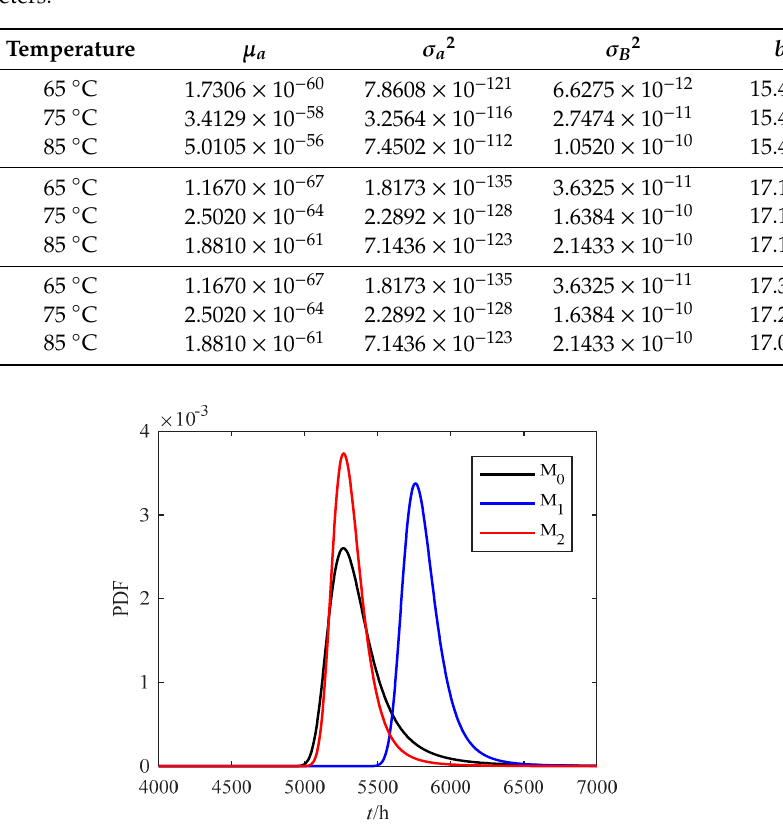
Figure 2. Comparison of PDF of lifetime at 65 °C for accelerometers.